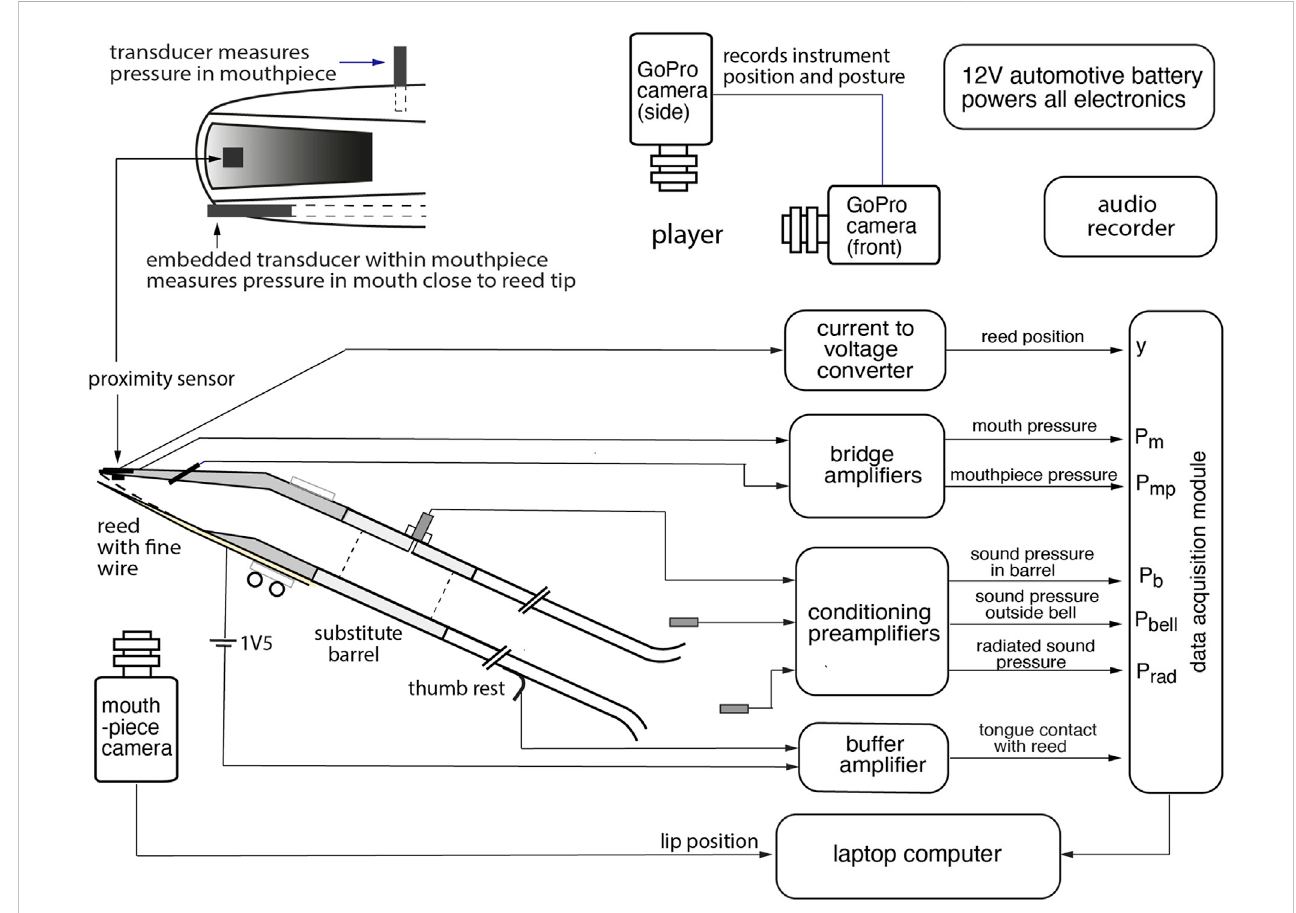
FIGURE 1 Schematic diagram (not to scale) of the overall measurement apparatus.